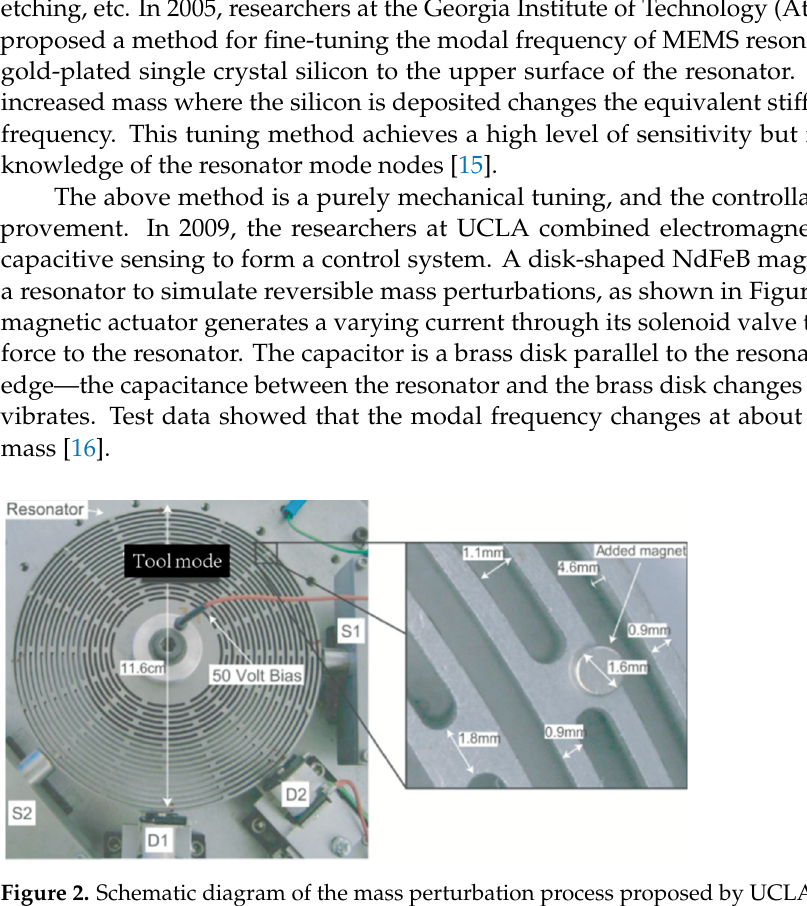
( b ) Figure 3. Schematic diagram of the structure of proposed mass perturbation tuning technology; ( a ) Structural diagram; ( b ) Reflow solder ball on the gold pad of the resonator In 2021, the National University of Defense Technology (Changsha, China) researchers reported a novel ring MEMS resonator and a novel method of mechanical frequency tuning. The most prominent characteristic of the resonator is that 16 raised mass blocks are increased uniformly in the circumferential positions of the ring. However, the stiffness of the resonator is almost unchanged, which shows that the scheme can realize the decoupling of mass and stiffness. The frequency difference has a linear relationship with the changed quality [68]. The above “mass addition” tuning method increases the equivalent mass of the gyro- scope, resulting in increased system power consumption. In 2001, the researchers at the University of Nottingham (Nottingham, UK) introduced the concept of “equivalent defect mass” for the first time, which was also the first time that the idea of “structural mass subtraction” was used. According to the Rayleigh–Ritz method, the researchers analyzed the effect of resonator mass imbalance on the modal error. They proposed the process of modal trimming by eliminating these mass imbalance errors at specific locations of the resonator. Still, this method only applies to trimming the edges of single and two pairs of oscillators [18].